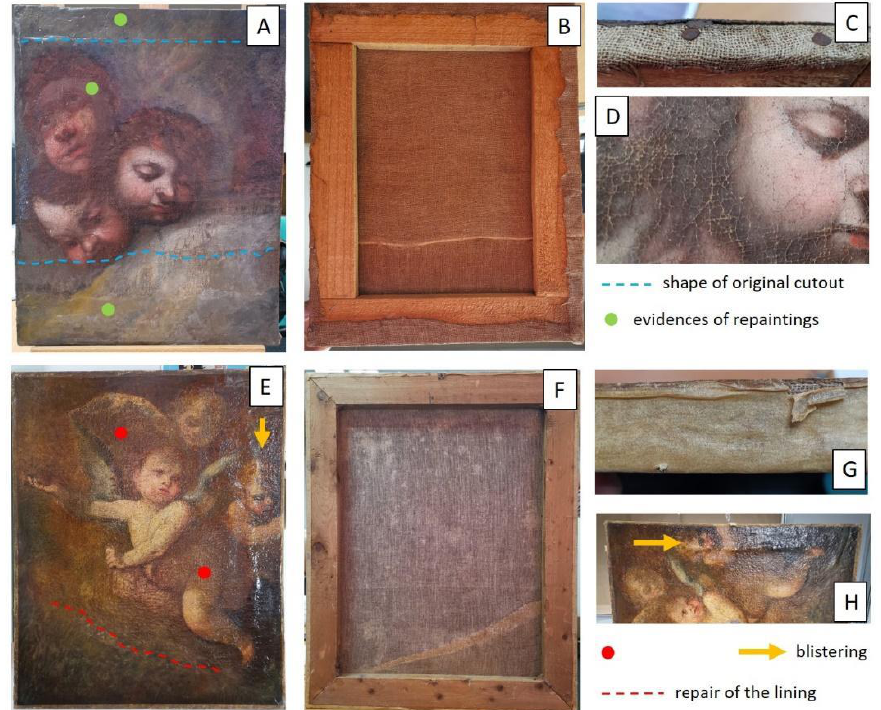
Figure 1. Front and back of the two fragments of oil paintings on canvas, attributable to the XVIII century: ( A – D ) Painting 1 (size: 35 cm × 30 cm); ( D , E ) Painting 2 (size: 75 cm × 60 cm). The degradation revealed during the first condition report is described in the legend. Details ( C , G ) show along the edges of the frame the cuts of the original canvas, attached to the lining canvas; ( D ) evidence of the original craquelure and use of a risparmio techniques, leaving the red-brown ground layer visible; ( F ) back of the lining canvas with an evident curved patch (red dashed line); and ( H ) wide blistering on Painting 2 highlighted by raking light observation.